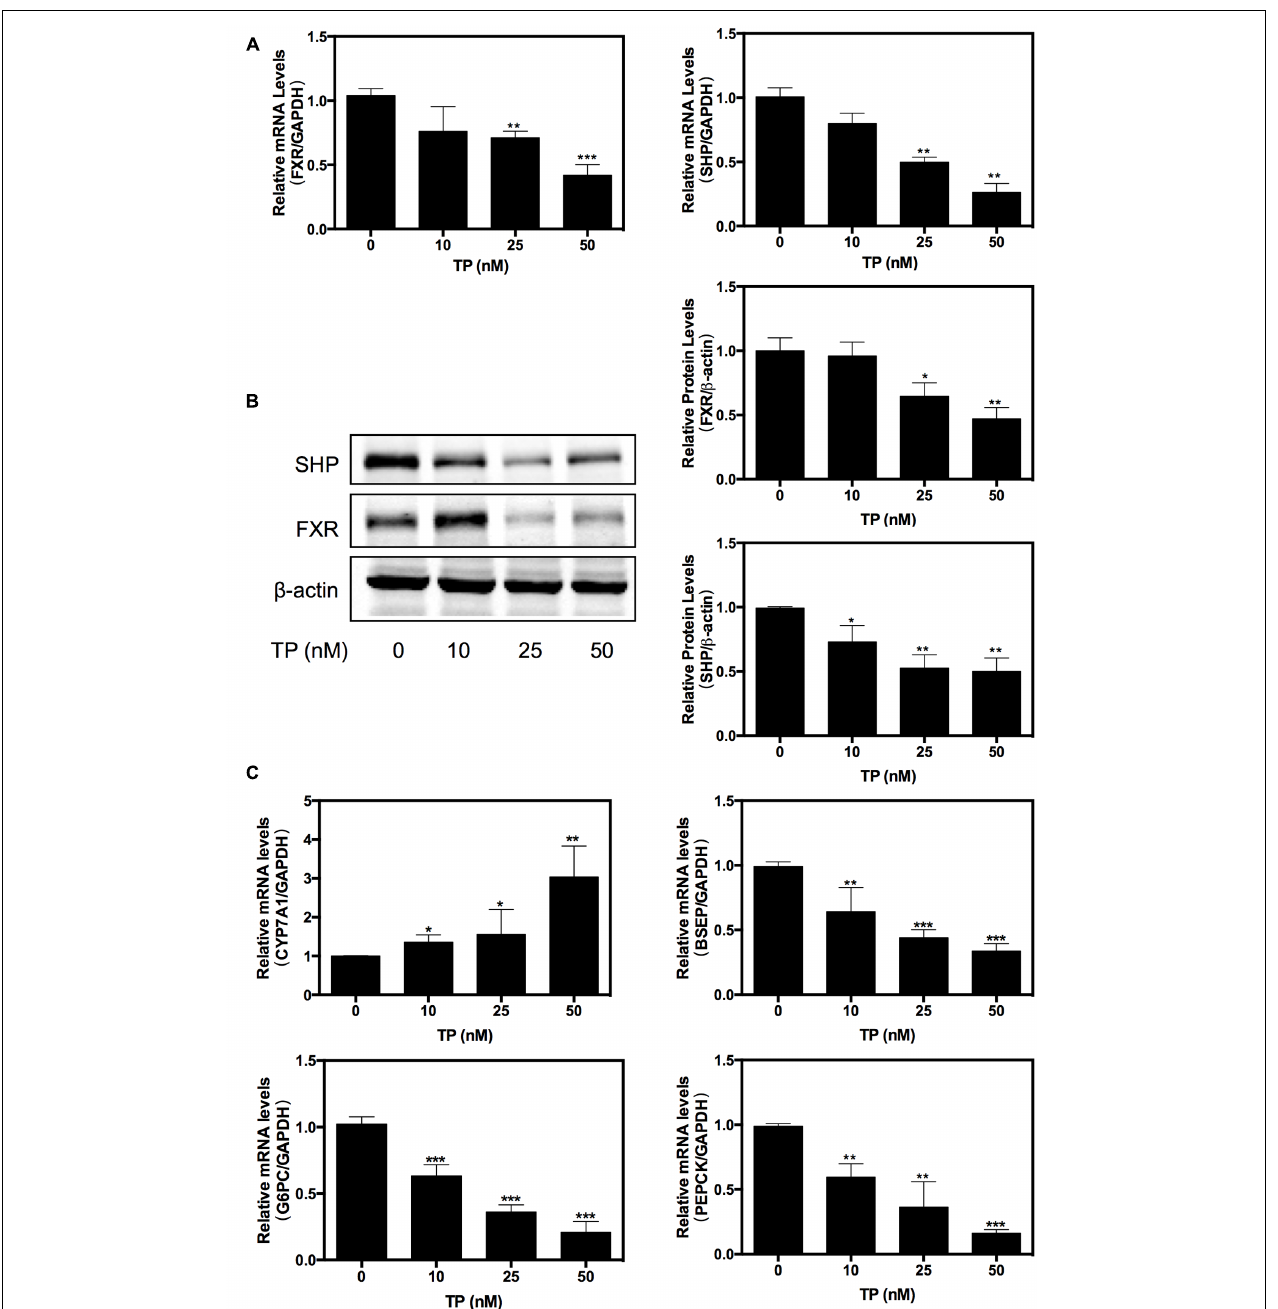
FIGURE 1 | Triptolide (TP) inhibits farnesoid X receptor (FXR) pathway in primary rat hepatocytes. Primary rat hepatocytes were treated with TP at various concentrations (0–50 nM) for 8 h. (A) The mRNA level of FXR was measured using real-time RT-PCR and normalized to GAPDH as an internal control. (B) The protein expression level of FXR was determined using western blot analysis and normalized to β -actin as a loading control. (C) The mRNA levels of FXR-target genes were measured using real-time RT-PCR and normalized to GAPDH as an internal control. Statistical significance relative to vehicle control: ∗ p < 0.05, ∗∗ p < 0.01, ∗∗∗ p <